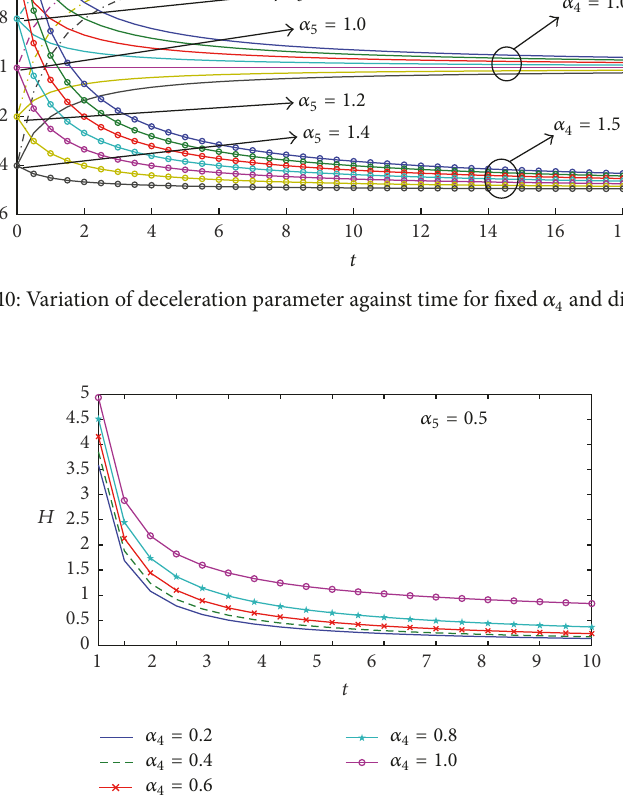
Figure 11: Variation of Hubble parameter against time for fixed 𝛼 5 = 0.5 and different 𝛼 4